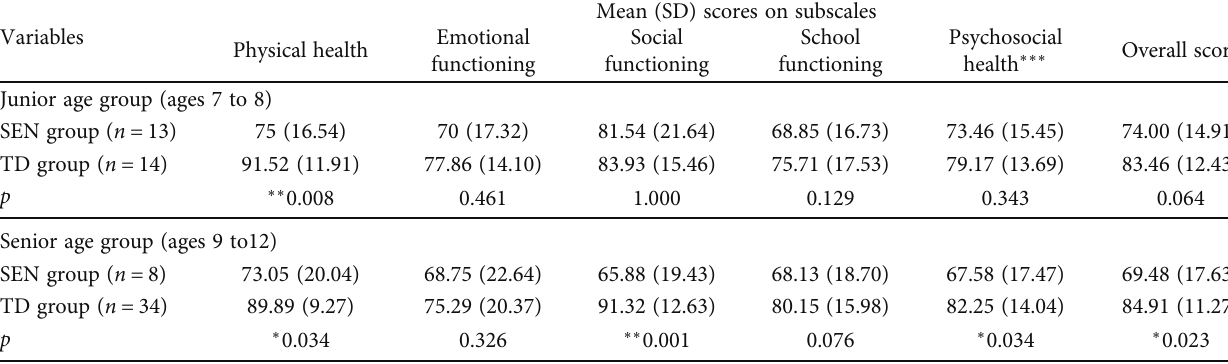
Table 5: Age comparison of PedsQL between children with SEN and TD.